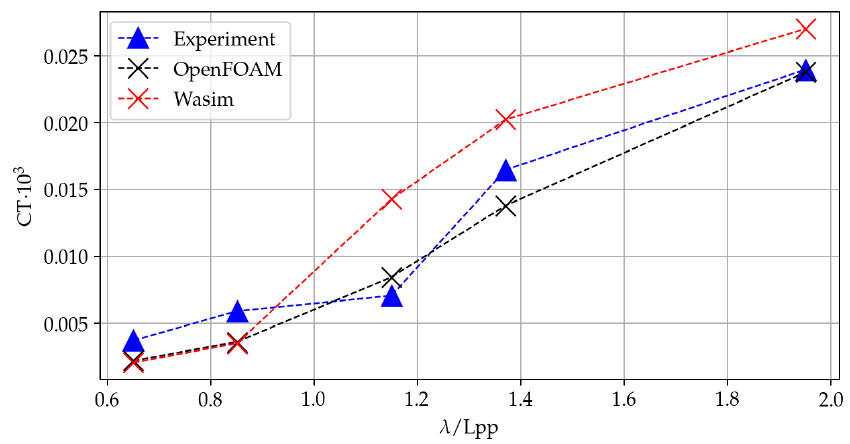
Figure 28. Transfer functions of pitch motion for the KRISO containership.